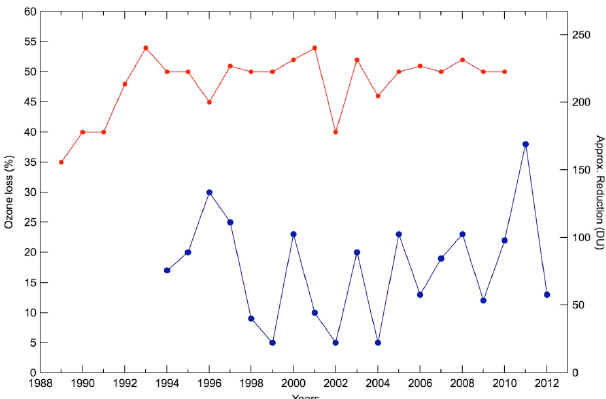
Fig. 13. Total ozone losses calculated between 1989–2012 from the SAOZ network and the passive ozone technique in the Arctic (blue) and the Antarctic (red, adapted from Kuttippurath et al., 2010). The amplitude of the 2011 Arctic depletion was similar to that of the 2002 Antarctic ozone hole.